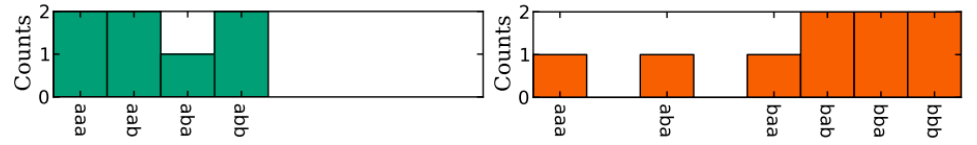
Figure 12. Example of two BOSS histograms.